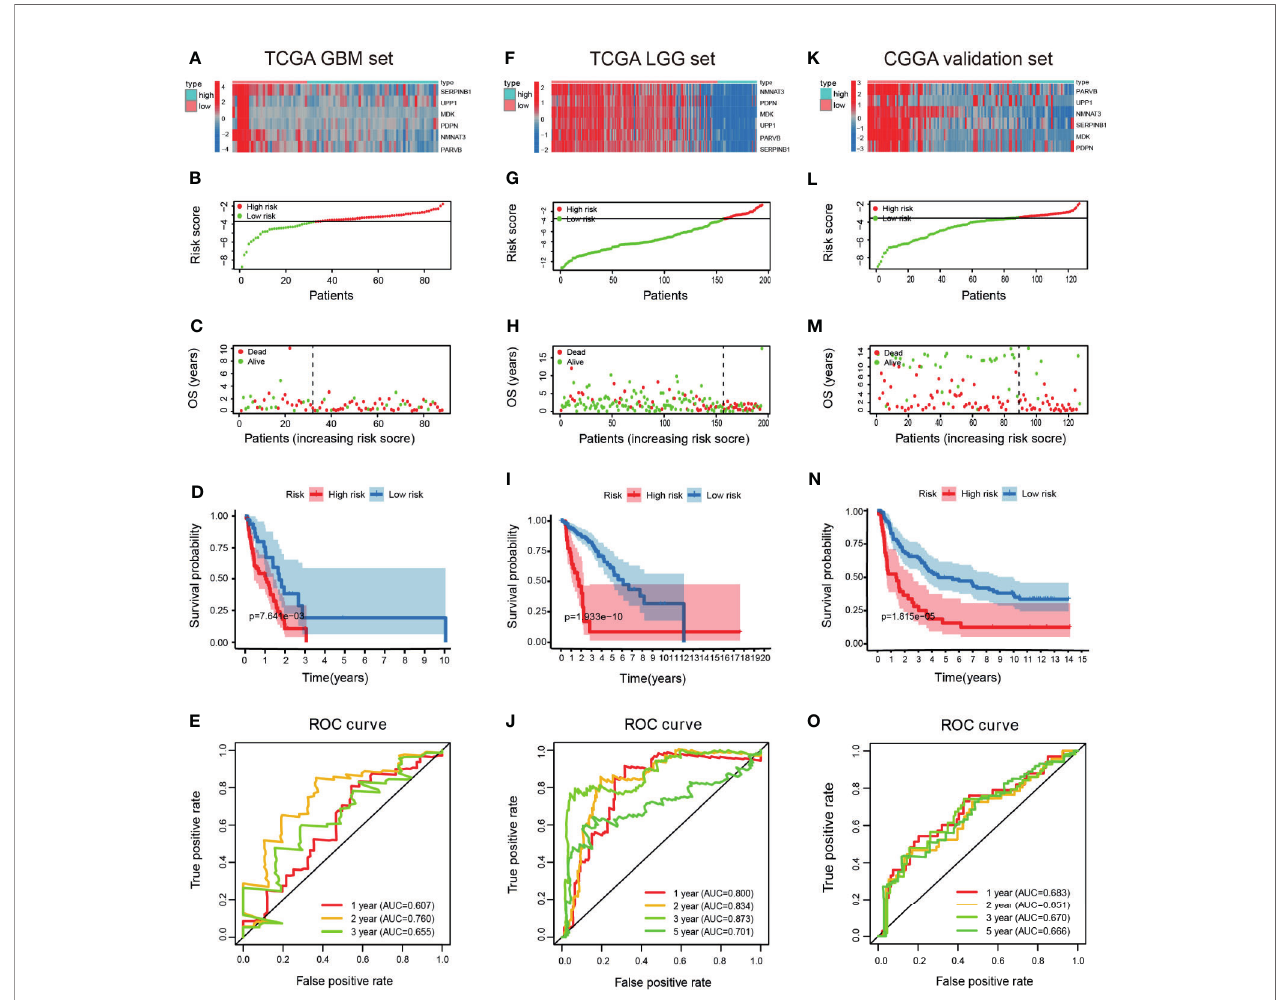
FIGURE 7 | Validation of the DMDG based risk score model in TCGA training cohort and CGGA validation cohort. (A) Heatmap of the 6-gene expression pattern: red represents upregulated genes and blue represents downregulated genes between low-risk and high-risk groups, (B) risk score analysis, (C) survival status analysis and (D) survival analysis in low- and high-risk groups in TCGA GBM set: the blue dots represent low-risk patients and red dots represent high-risk patients. (E) ROC curve analysis in TCGA GBM set within 1-, 2-, and 3-years. (F – I) Heatmap of the 6-gene expression pattern, risk score analysis, survival status analysis, and survival analysis in low- and high-risk groups in TCGA LGG set. (J) ROC curve analysis in TCGA LGG set within 1-, 2-, 3- and 5-years. (K – N) Heatmap of the 6-gene expression pattern, risk score analysis, survival status analysis and survival analysis in low and high-risk groups in CGGA validation set. (O) ROC curve analysis in CGGA validation set within 1-, 2-, 3- and